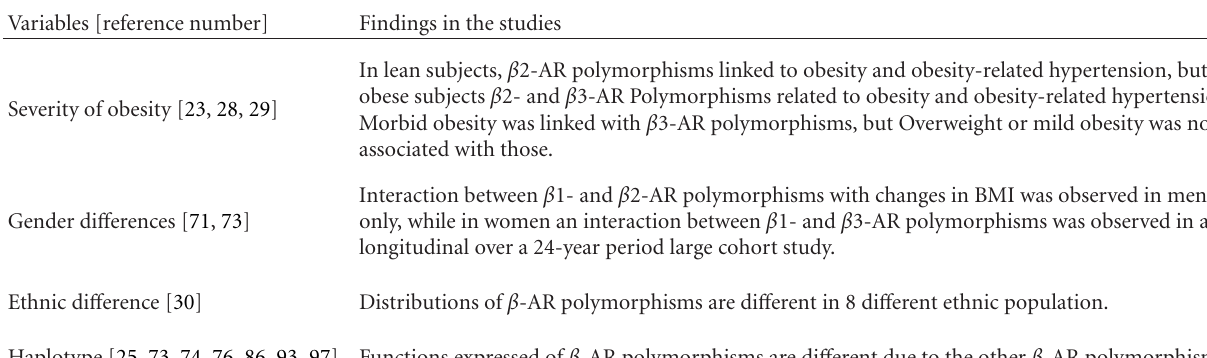
Table 4: Confounding variables considered to cause the discrepancy of the relationships between β -adrenoceptor polymorphisms and phenotypes of obesity, hypertension, and